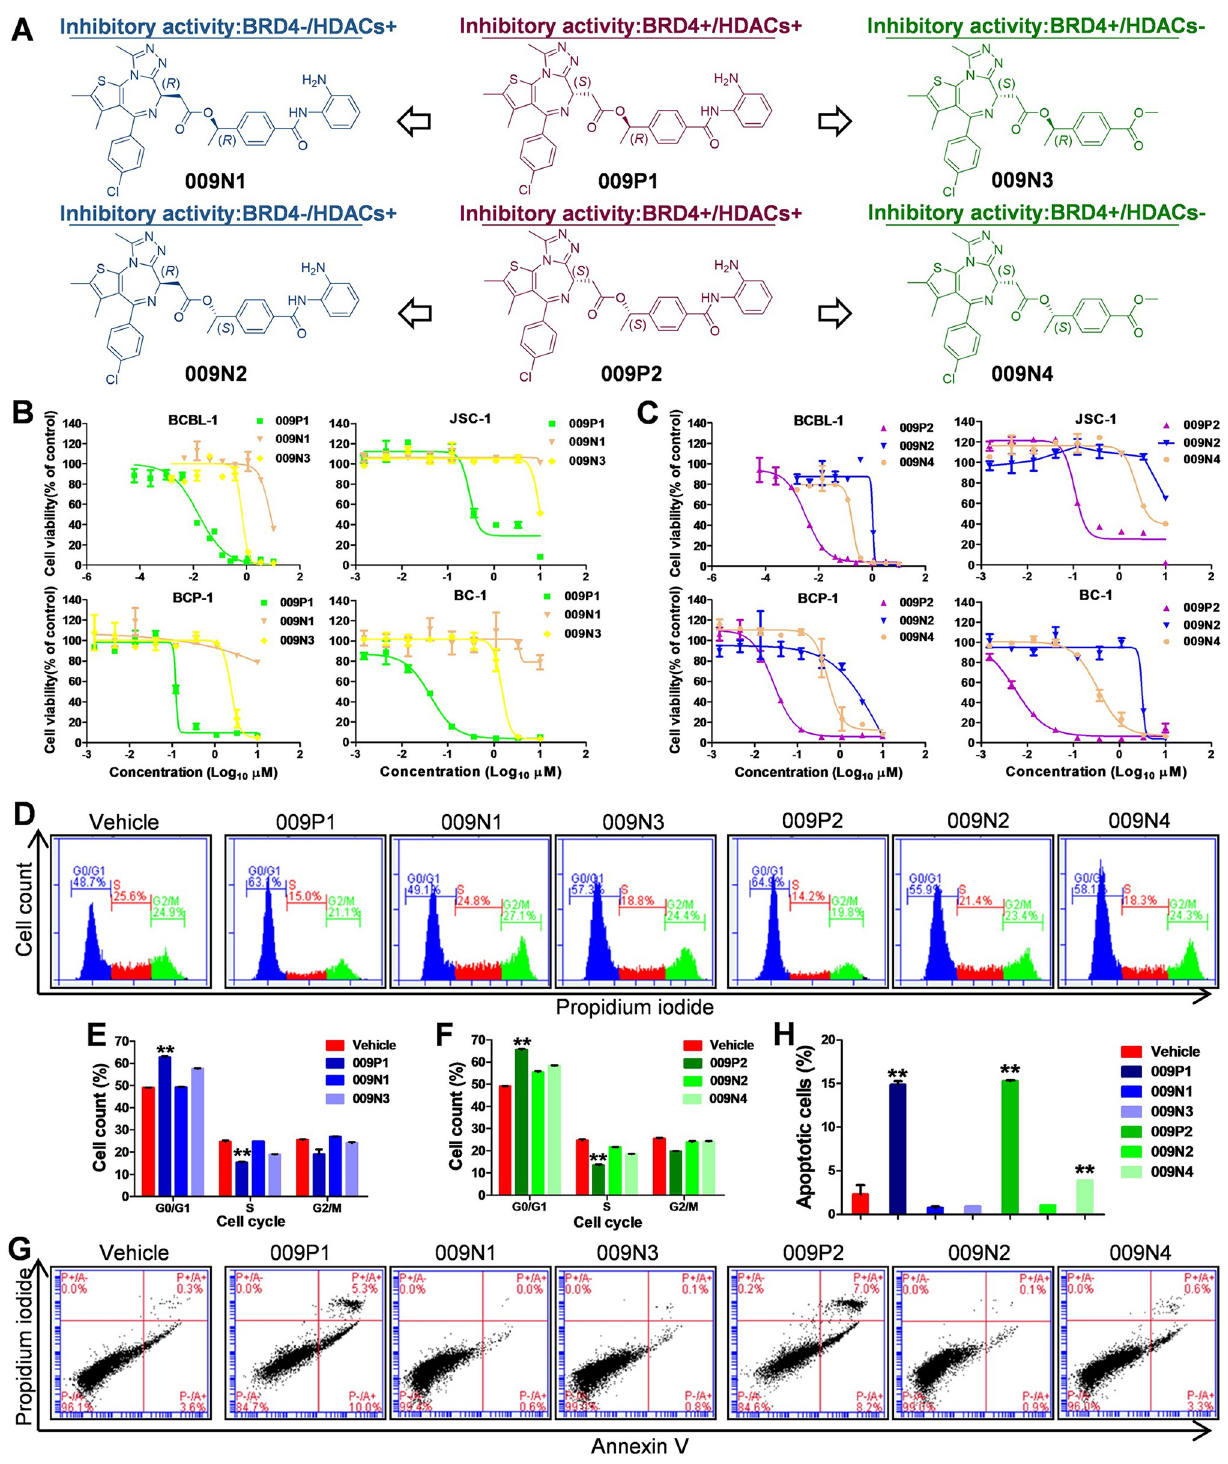
Fig 4. Identification of anti-PEL activities for compound 009 stereoisomers. ( A ) The chemical structures of anti-HDACs/BRD4 bifunctional molecules 009P1 and 009P2, as well as anti-HDACs or anti-BRD4 mono-functional molecules 009N1, 009N2, 009N3, and 009N4. ( B-C ) Four KSHV + PEL cell lines were treated with indicated concentrations of 009P1, 009P2 or 009N1-N4 for 72 h, then the cytotoxicity was determined using the WST-1 assay. ( D-I ) BCBL-1 cells were treated with these compounds at the respective 2 × CC 50 for 24 h, then cell cycle (D-F) and apoptosis (G-I) were measured by flow cytometry analysis. Error bars represent S.D. for 3 independent experiments, �� = p < 0.01 (vs vehicle control).